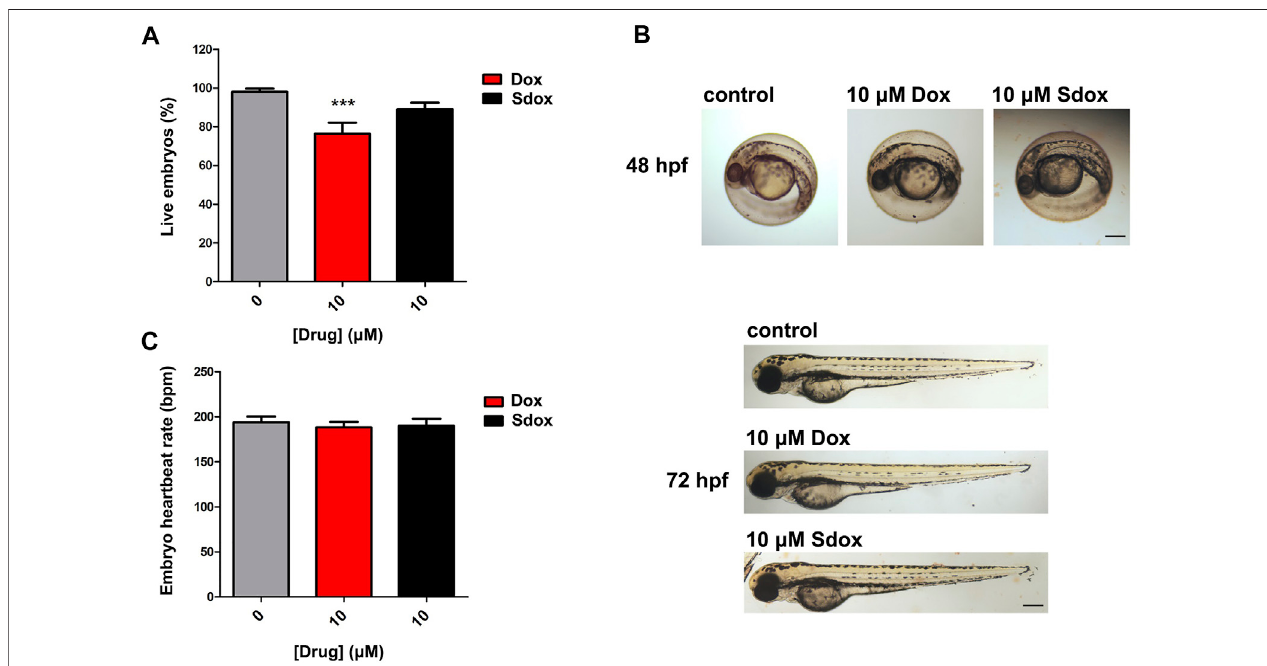
FIGURE 7 | Effect of Dox and Sdox on zebra fi sh. (A) Seventy-two hours post fertilization zebra fi sh embryos survival. (B) Representative images of Dox- or Sdox- treated zebra fi sh embryos at 48 and 72 hpf. Images of zebra fi sh embryos at 72 hpf are panorama images. Scale bar = 500 µm. (C) Heartbeat rate in 72 hpf zebra fi sh embryos after treatment with Dox and Sdox. Columns are mean ± SD. *** p < 0.001 vs. control (0), one-way ANOVA with Dunnett ’ s